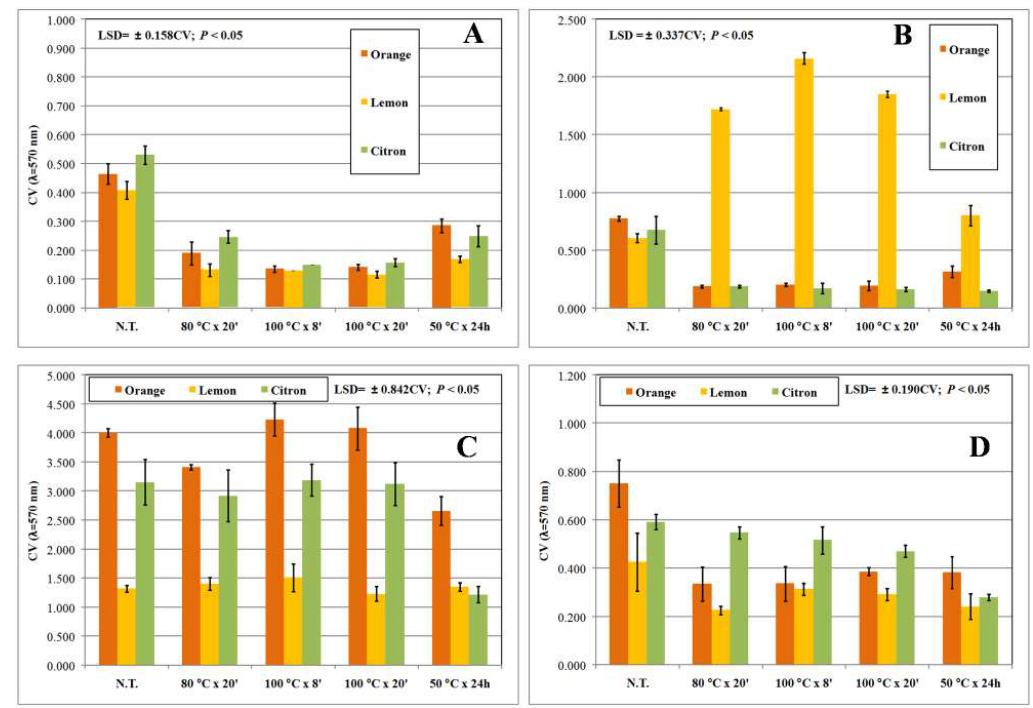
Figure 4. Biofilm biomass produced by S. caprae DSM 20608 ( A ), S. epidermidis UR63 ( B ), S. saprophyticus UR18 ( C ), and S. xylosus DSM 20266T ( D ) in the presence of different citrus peel water extracts. Mean values (bars ± standard deviation) from the same strain were compared by Fisher’s least significant difference (LSD) multiple-comparison test (95% Confidence Intervals); N.T.: not treated.